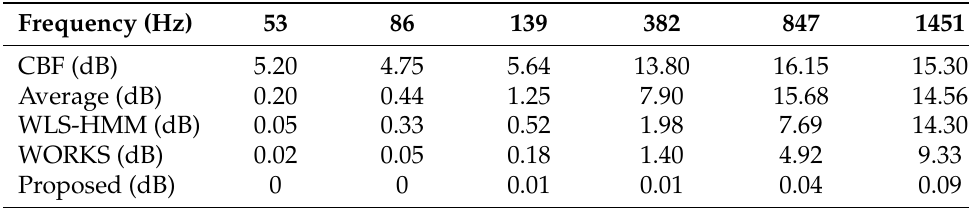
Figure 5. Performance comparisons. ( a ) Beam power pattern based on the hypothetical uniform linear array. ( b ) The estimates of the time-delay difference between the first two hydrophones for 50 frames of observation. ( c ) The estimates for inter-hydrophone time-delay difference of the distorted towed array at the 17th observation. ( d ) The average for the power spectrum of the enhanced signal in 50 frames of observation. Table 2. Amplitude errors of line-spectrum